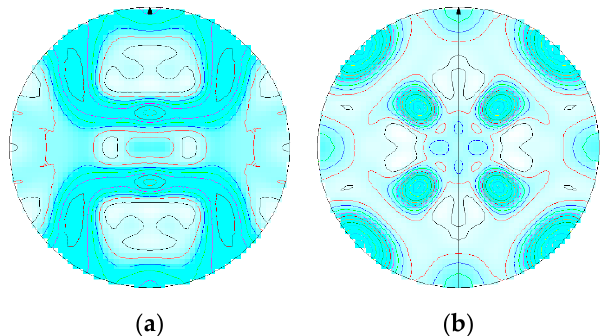
Figure 5. Recalculated {200} pole figures of the samples cold-rolled in 12 steps. ( a ) A10; ( b ) A11K.